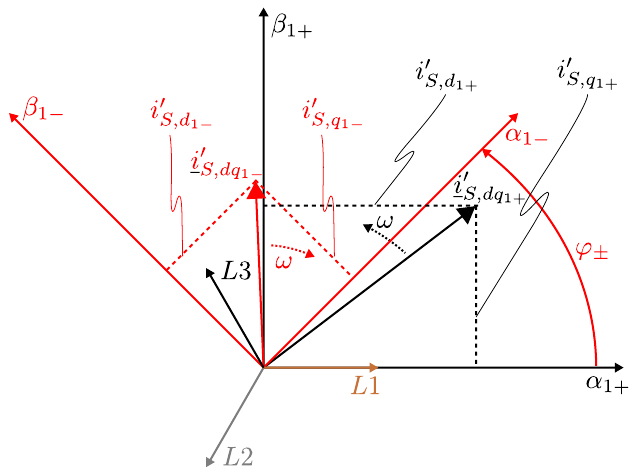
Figure 2. Vector diagram to derive the calculation for the current limitation (valid only for ω t =